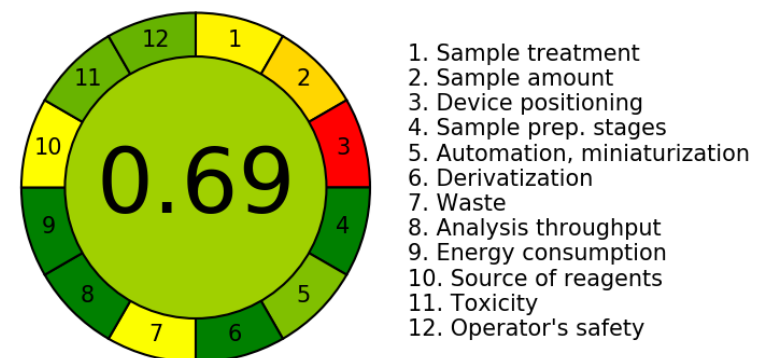
Figure 4. ComplexGAPI pictograms for SA-DLLME TLC-DIC: ( a ) for pharmaceutical samples, and ( b ) for biological samples.